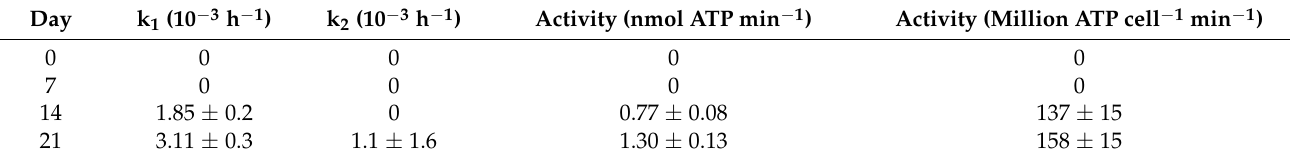
Table 2. Kinetic constants of extracellular ATP hydrolysis by MOVAS cells on days 0, 7, 14, and 21 corresponding to the best fits (Figure S1). After 0, 7, 14, and 21 days, 5 mM of levamisole was added just before the enzymatic